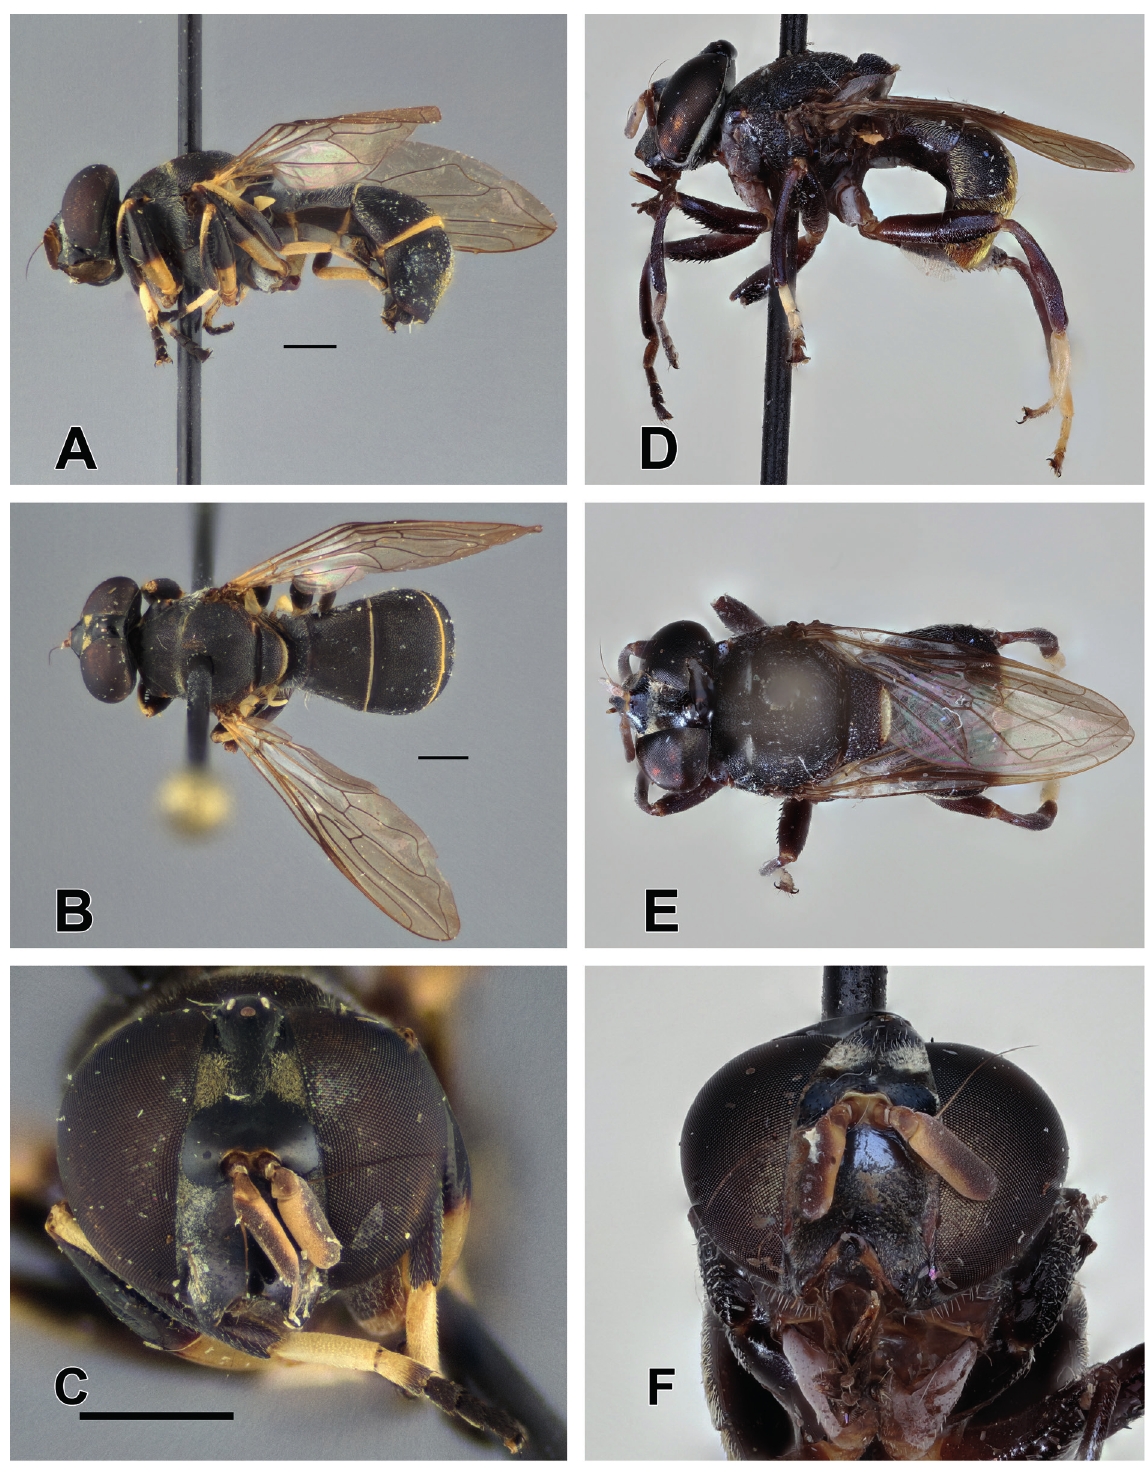
Fig. 3. A–C . Myolepta diaphora sp. nov., ♀, holotype (ZFMK-DIP-00082516). A . Habitus, lateral view. B . Habitus, dorsal view. C . Head, frontal view. D–F . M. orientalis Thompson, 1971, ♀, holotype (BPBM). D . Habitus, lateral view. E . Habitus, dorsal view. F . Head, frontal view. Scale bars: A–C = 1